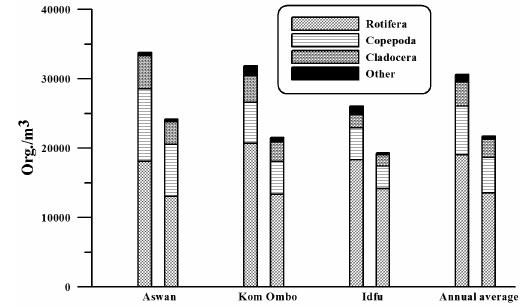
Figure 8. Spatial distribution of the Nile zooplankton groups in Upper Egypt. Left bar (upstream) and right bar (Downstream).